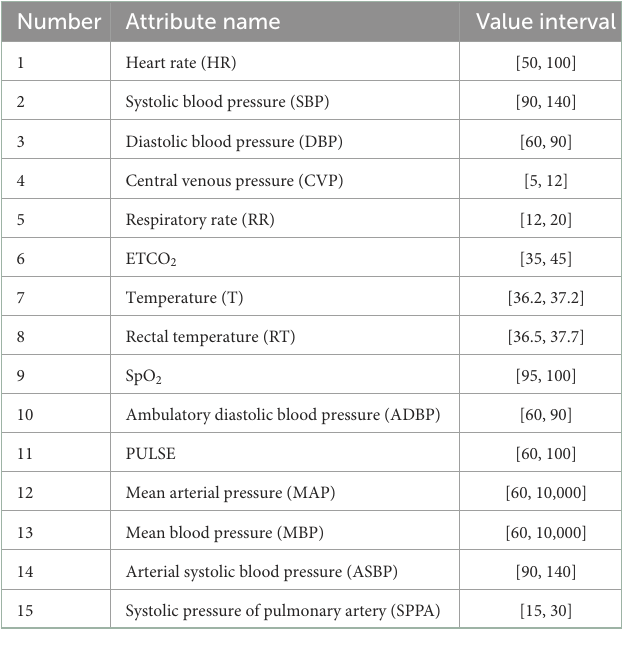
TABLE 1 Normal value range of patient monitoring attributes during operation.